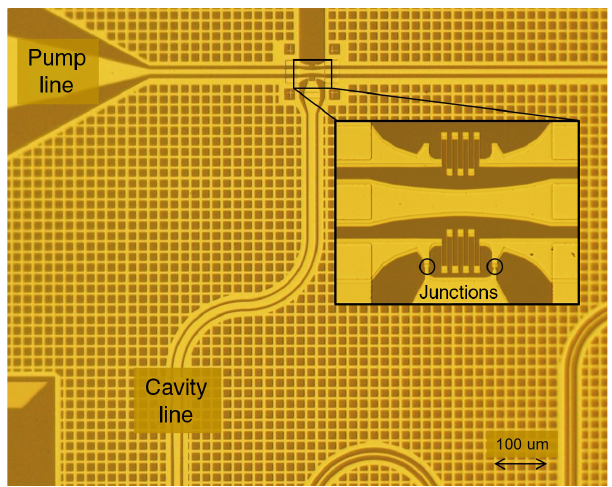
FIG. 1. Meandered SQUID design with improved pump cou- pling. The narrow, meandered path is shared between the SQUID and the ground plane of the pump line. The kinetic inductance of the meander then directly couples the pump current in the ground plane to the SQUID phase. The center conductor of the pump line is narrowed to reduce its magnetic coupling to the SQUID, which contributes with the opposite sign of the kinetic coupling. Following microwave simulations, a mirrored structure is pat- terned in the top ground plane, such that the ground current divides evenly between the two ground planes. Compared to previous designs, we find a reduction in the pump strength required for TPDC by 3 orders of magnitude. The reduction greatly reduces the spurious effects of strong pumping and is critical to realizing three-photon